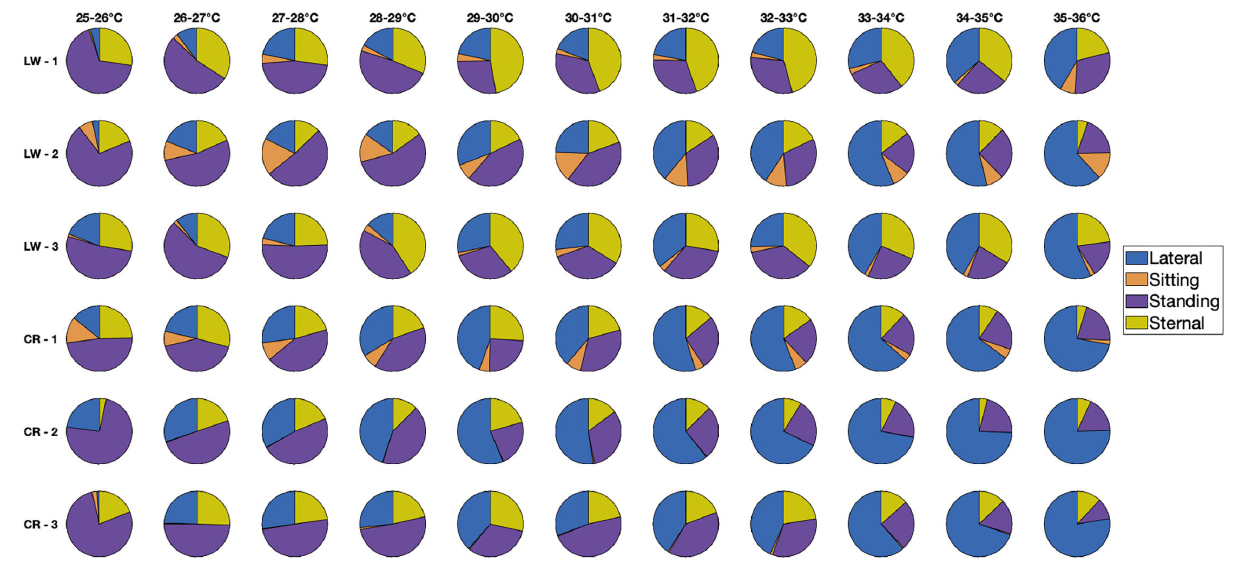
FIGURE 3 | Posture distribution as a function of temperature class. Each row corresponds to one animal and each column to one temperature